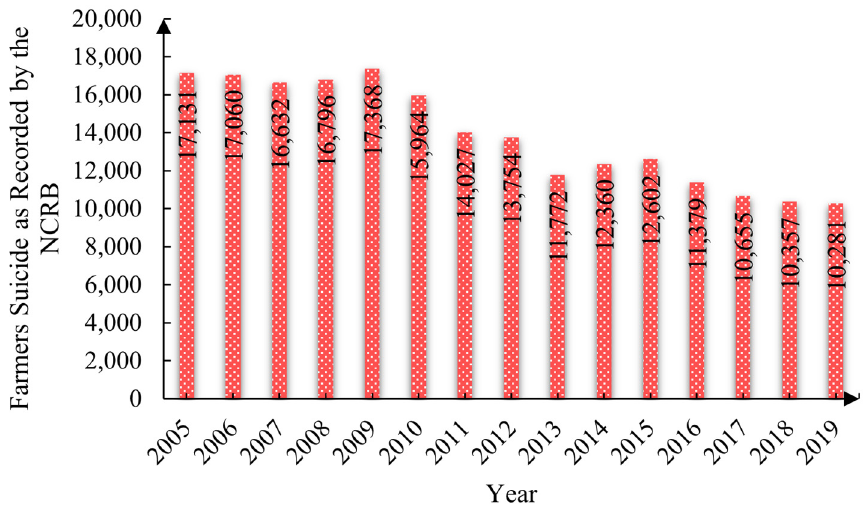
Figure 4. Farmer suicides from 2005 to 2019 according to NCRB data.